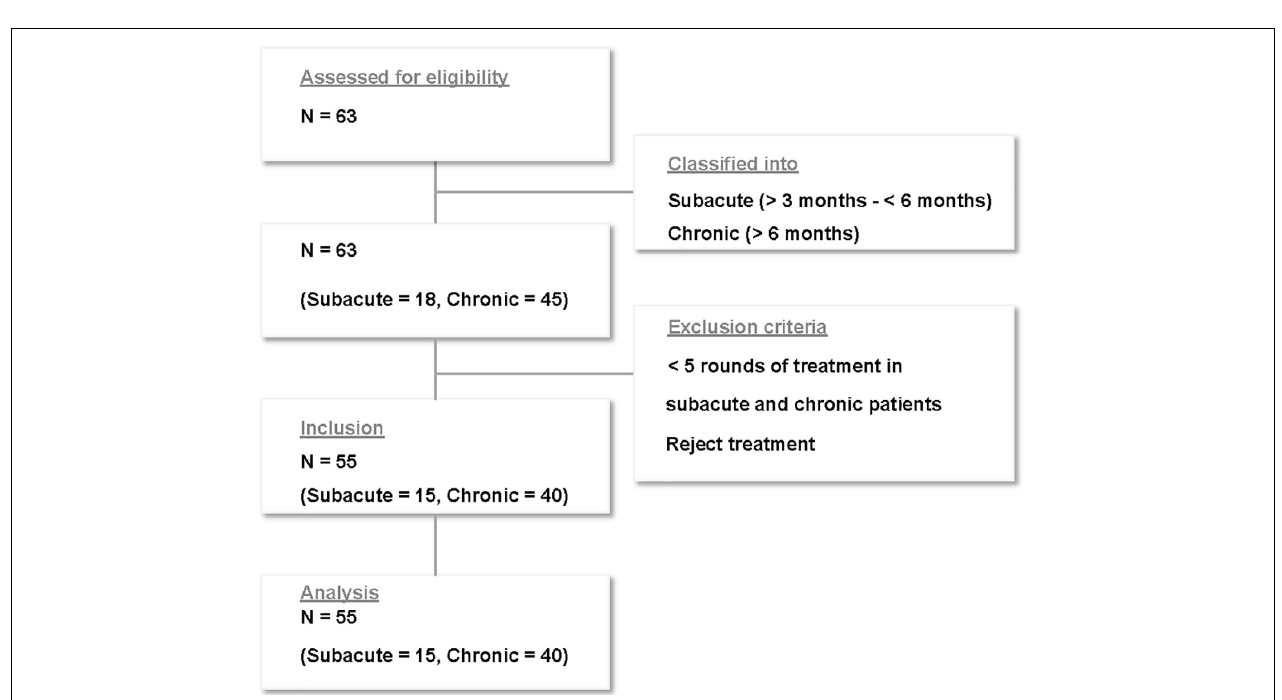
FIGURE 1 | Shown is a simplified smiley tinnitus-visual analog scale (T-VAS) measuring loudness, distress, and quality of life (QOL). 0, no sound, no distress or discomfort, usual QOL; 2, weak, no to mild distress and discomfort, not bad QOL; 4, moderately loud, mild to moderate distress, slightly bad to bad QOL; 5, loud to not very loud, mild to moderately severe distress, moderately bad to bad QOL; 6, loud to not very loud, mild to moderately severe distress, moderately bad to bad QOL; 8, very loud to loud, moderate to very severe distress, bad to severely impaired QOL; 10, extremely or unbearably loud, severe to worst distress, fear, severely impaired to worst QOL.